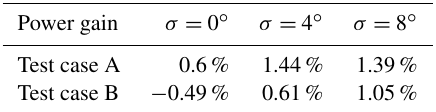
Table 1. Summarized power gains for test cases A and B and the different robustness parameters.